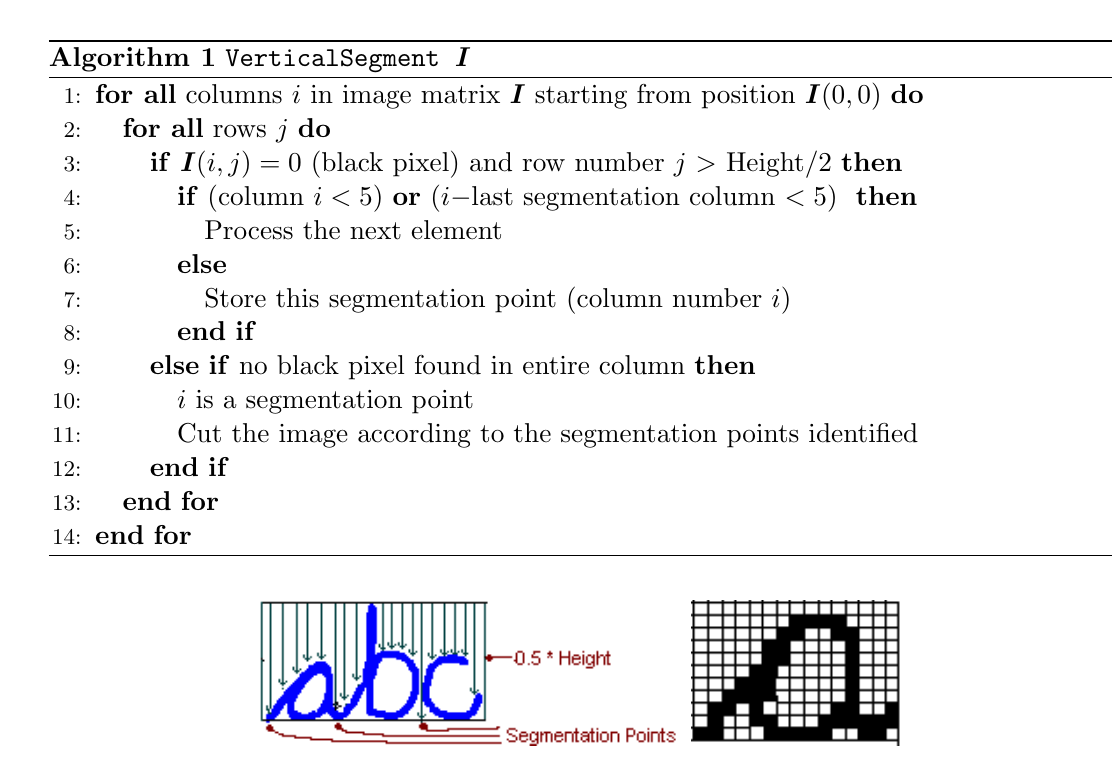
Figure 2: Vertical segmentation technique and binary representation of a